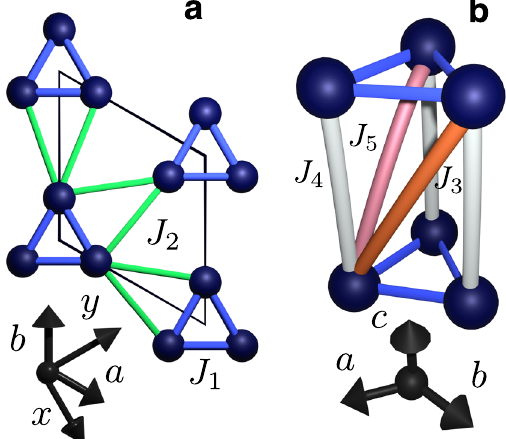
Fig. 1 The Fe-langasite crystal structure. a Spin triangles in the crystallographic ab plane formed by Fe 3 + ions (blue spheres). Blue lines mark the bonds between the spins in the triangles with the relatively strong AFM exchange interaction J 1 . The triangles form a hexagonal lattice with the AFM coupling J 2 between the triangles. b Stacking of the spin triangles along the c axis with the competing AFM interactions J 3 , J 4 , and J 5 between the spins in neighboring triangles.